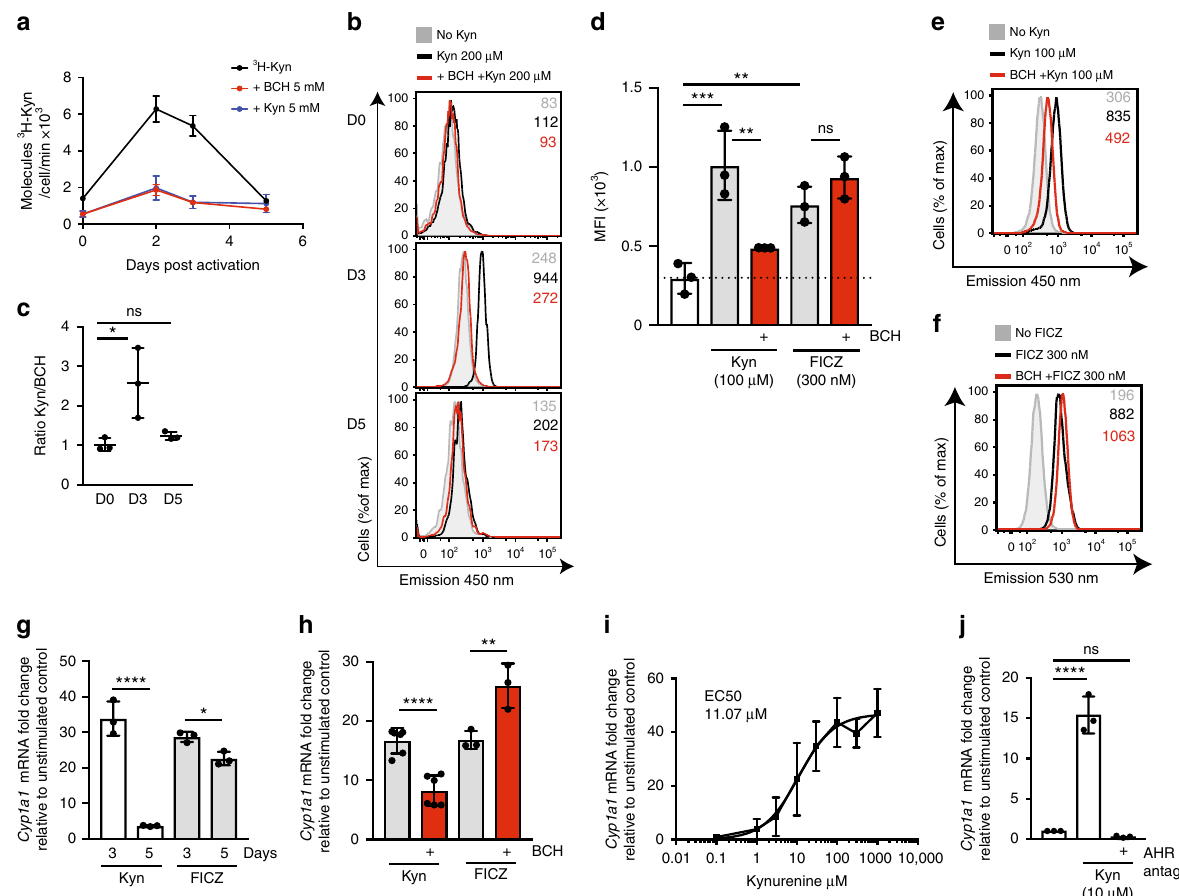
Fig. 5 System L-mediated transport of kynurenine drives AHR signalling. a CD4 + T cells were activated and maintained in TH17 conditions (CD3/CD28; IL- 6, IL-1 β and TGFb) (TH17 cond ). Uptake of 3 H-kynurenine in the presence or absence of BCH (5 mM) or non-radiolabelled kynurenine (5 mM) at times D2, D3 and D5 post activation is shown. b Histograms showing 450 nm fl uorescence of D0, D3 and D5 TH17 cond CD4 + T cells treated with kynurenine (200 μ M, 4 min) in the presence or absence of BCH (5 mM), or with no kynurenine. c Ratio of the 450 nm emission of D0, D3 and D5 TH17 cond CD4 + T cells treated with kynurenine ± BCH 5 mM (4 mins, 37 °C). d The graph shows the mean fl uorescence intensity (MFI) of D3 TH17 cond CD4 + T cells treated with kynurenine (100 μ M, 4 min, emission 450 nm) or FICZ (300 nM, 4 min, emission 530 nm) in the presence or absence of BCH (10 mM). e , f Representative fl ow cytometry histograms of ( d ); kynurenine uptake ( e ) and FICZ uptake ( f ). g The graph shows Cyp1a1 mRNA from D3 or D5 TH17 cond CD4 + T cells stimulated with kynurenine (100 μ M, 2 h) or FICZ (300 nM, 2 hr), relative to non-treated control. h Induction of Cyp1a1 mRNA in D3 TH17 cond CD4 + T cells stimulated with kynurenine (100 μ M, 2 h) or FICZ (300 nM, 2 h) in the presence or absence of BCH (25 mM). The data are shown relative to non-treated control. i Dose – response induction of Cyp1a1 mRNA in D3 TH17 cond CD4 + T cells stimulated with kynurenine at indicated doses for 2 h. The data are shown relative to non-treated control. j Induction of Cyp1a1 mRNA in D3 TH17 cond CD4 + T cells stimulated with kynurenine (10 μ M, 2 h) in the presence or absence of AHR antagonist (CH223191, 30 μ M). The data are shown relative to non-treated control. Error bars are ±s.d. Individual points indicate biological replicates. MFIs are indicated in the histograms, data are from three biological replicates ( a – g , i – j ) and six (Kyn) or three biological replicates (FICZ) ( h ). P values * = < 0.01; ** = < 0.005; *** = < 0.001; **** = < 0.0001; ns = not signi fi cant (ordinary one-way